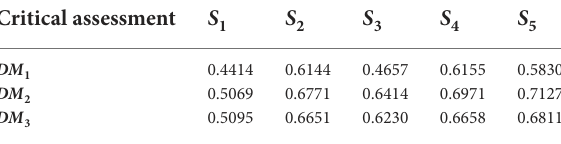
TABLE 10 Critical assessment of five alternatives for three decision makers. Critical